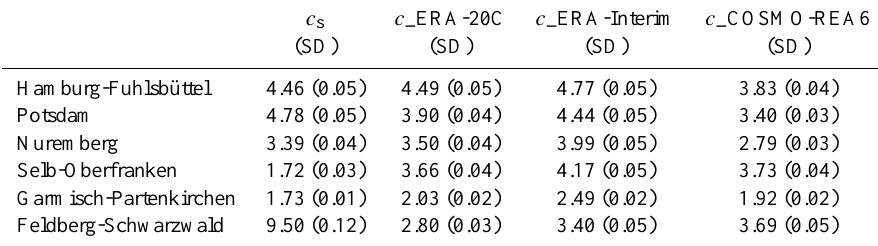
Table 2. Weibull parameters c (scale) derived from selected station daily mean wind observations ( c s ), and from ERA-20C, ERA-Interim, and COSMO-REA6 interpolated grid cells matching the station locations, together with their 1 σ standard deviations